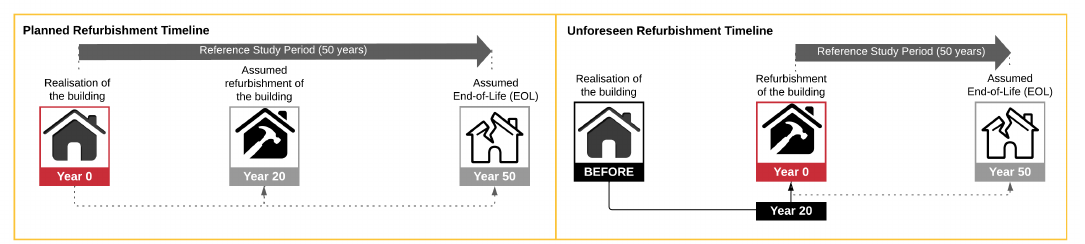
Figure 1. Timeline for planned and unforeseen